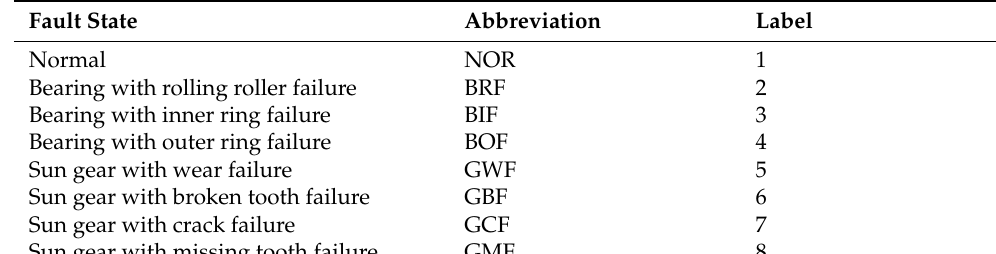
Table 3. Fault states of planetary gearboxes.